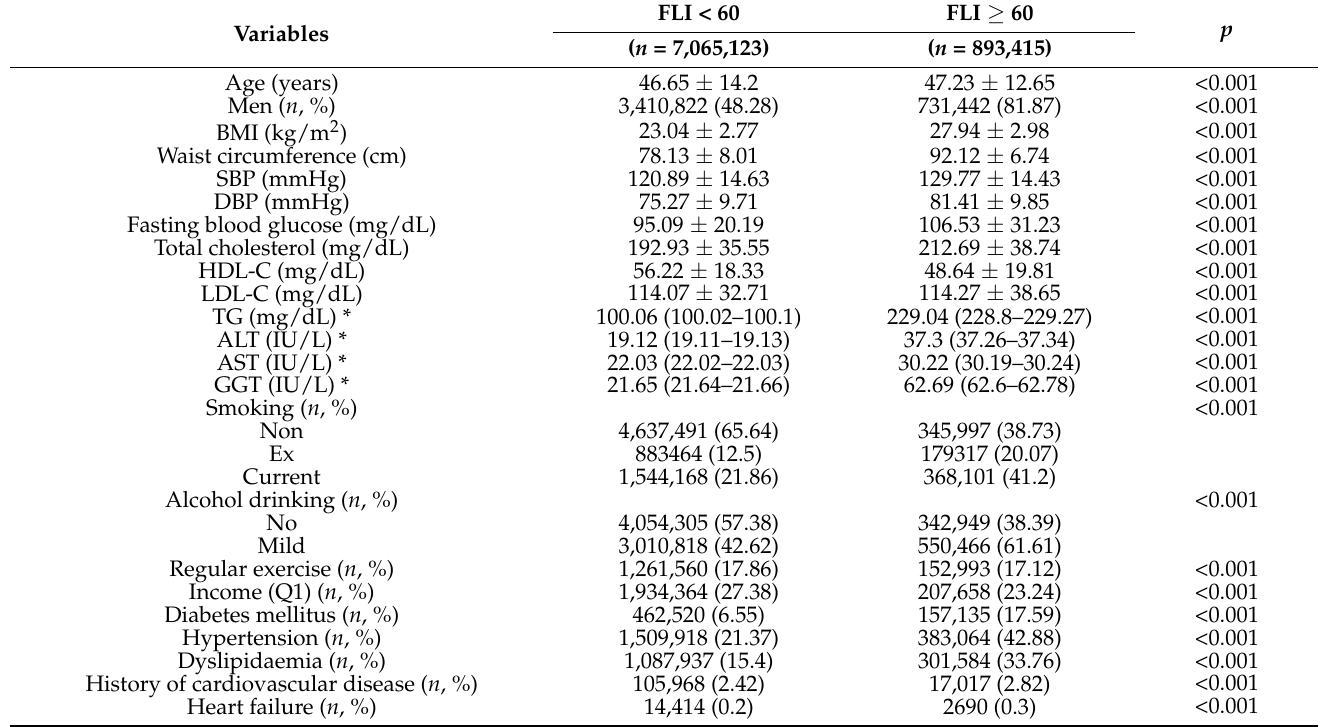
Table 1. General characteristics of participants according to fatty liver index ≥ 60 or